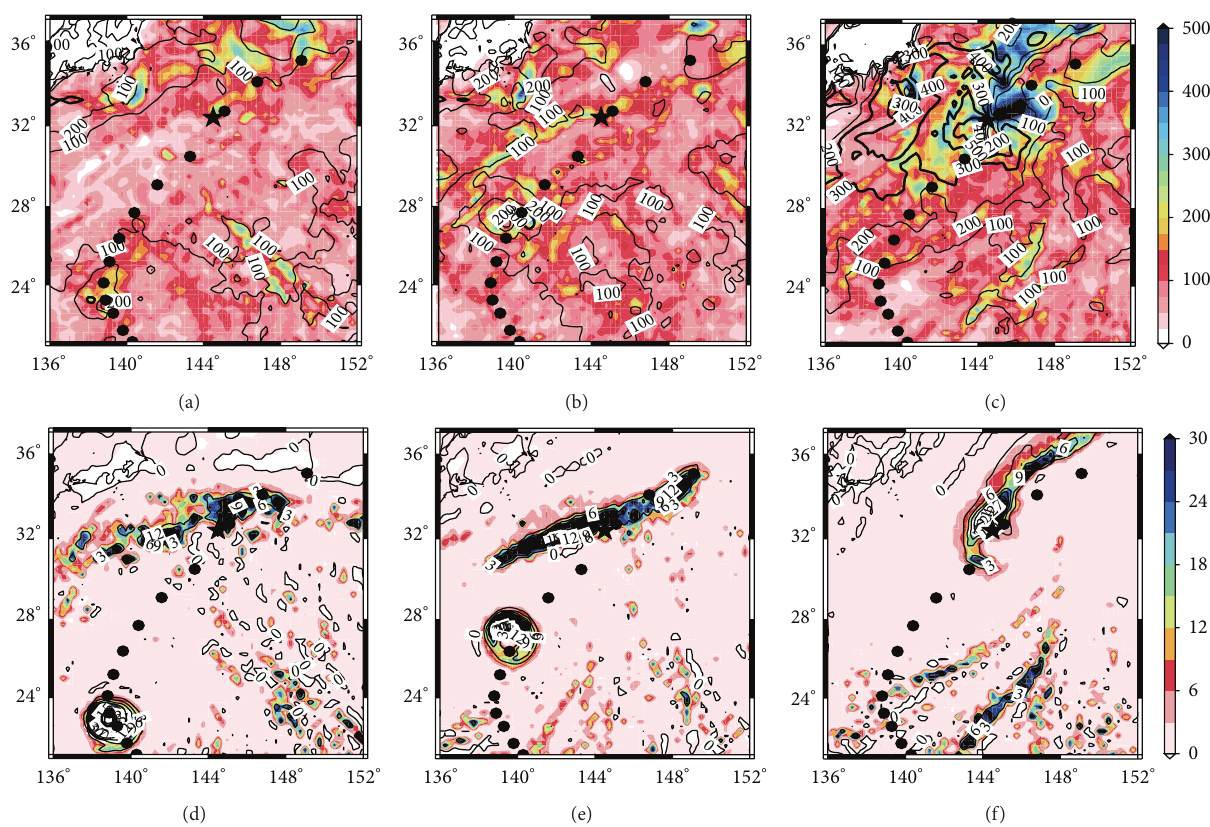
Figure 12: Same as Figure 10 except for (a–c) sea to air latent heat flux and (d–f) hourly precipitation at (a, d) 24 h, (b, e) 48 h, and (c, f) 69